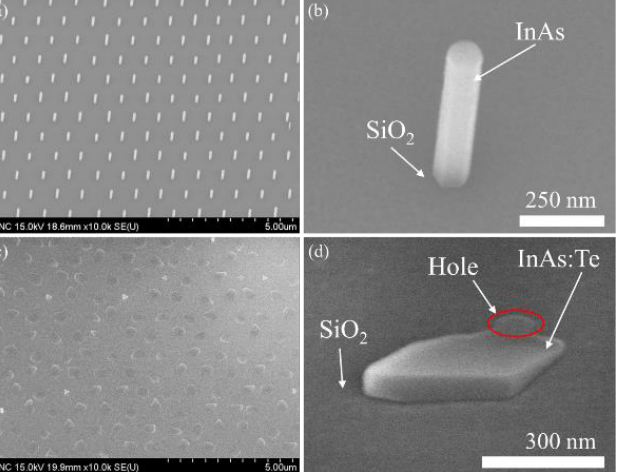
Figure 1. Tilted-view SEM images and high-resolution SEM images of ( a , b ) un-doped InAs NWs; ( c , d ) Te-doped InAs NWs without seed NWs at DETe gas flow (4.04 × 10 − 5 sccm). In contrast, adding DETe (the gas flow: 4.04 × 10 − 5 sccm) for Te doping under